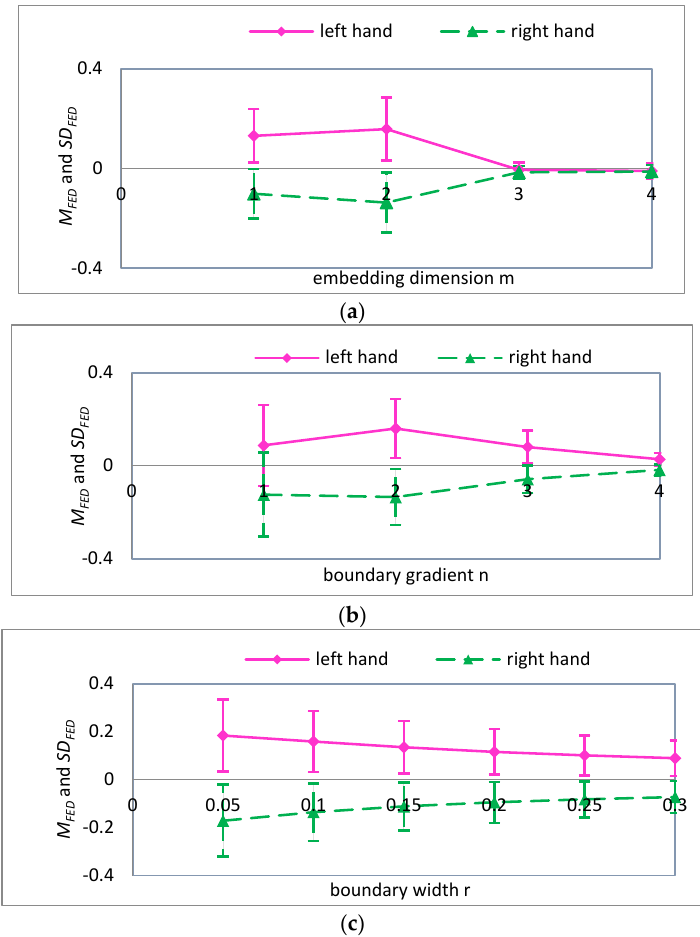
Figure 8. For =3 τ , the mean and standard deviation of FED curves for input variables ( a ) embedding dimension m ; ( b ) boundary gradient n ; and ( c ) boundary width r .